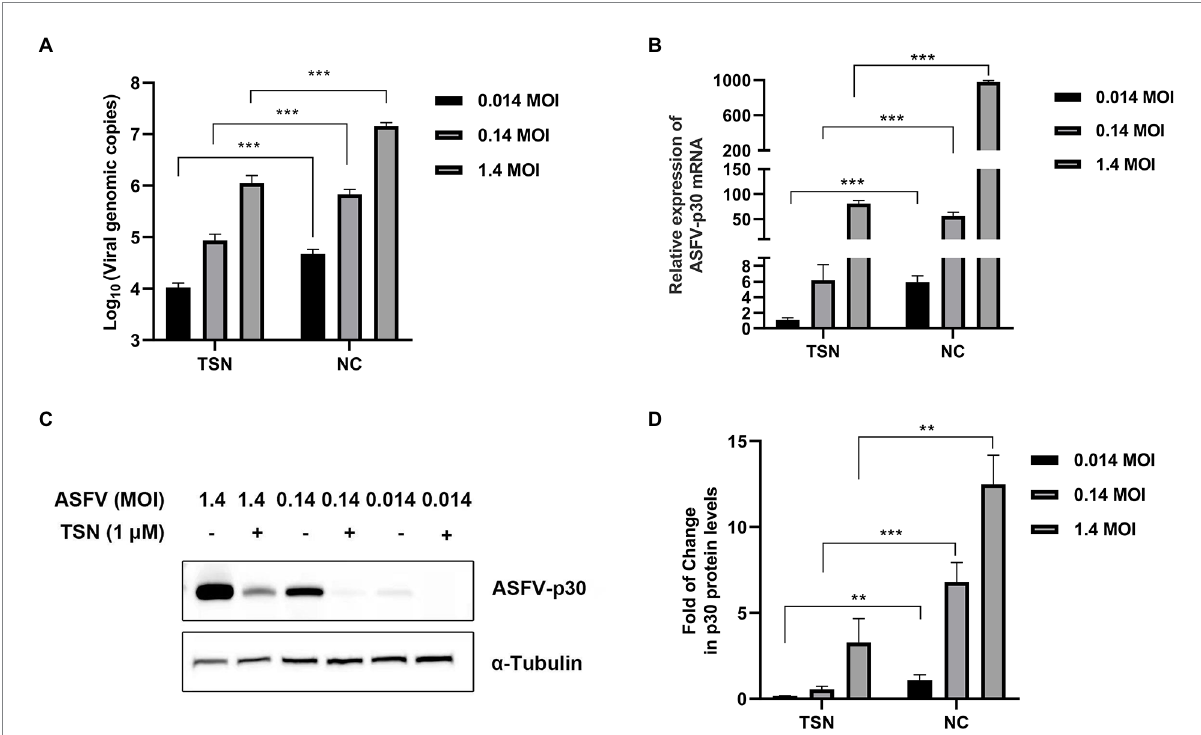
FIGURE 3 Antiviral effects of TSN against different challenge doses of ASFV in PAMs. PAMs seeded in 24-well or 48-well plates were challenged with different ASFV doses and treated with 1 μ M TSN. The negative control was infected with ASFV without TSN treatment. The samples were subjected to qPCR, RT-qPCR, and Western Blot at 24 hpi. (A) The DNA level of the ASFV p72 gene was analyzed using qPCR. (B) The mRNA level of the ASFV p30 gene was analyzed using RT-qPCR. (C) The expression of viral p30 protein was detected by Western Blot. (D) The densitometric analysis of p30 from (C) was performed using the ImageJ software. *** denotes p < 0.001; ** denotes p < 0.01. NC denotes the negative